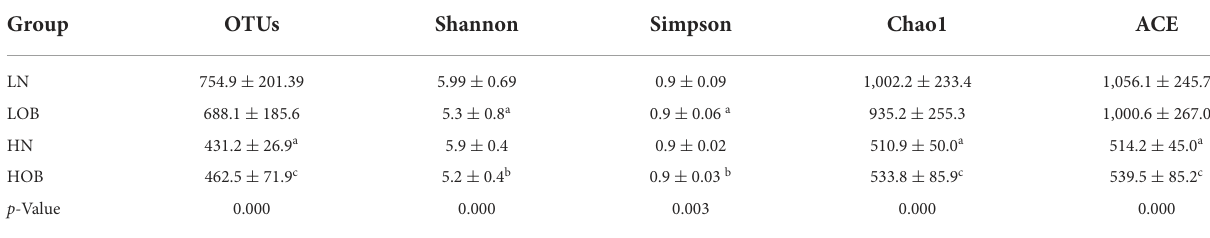
TABLE 2 Fecal microbial HiSeq sequencing